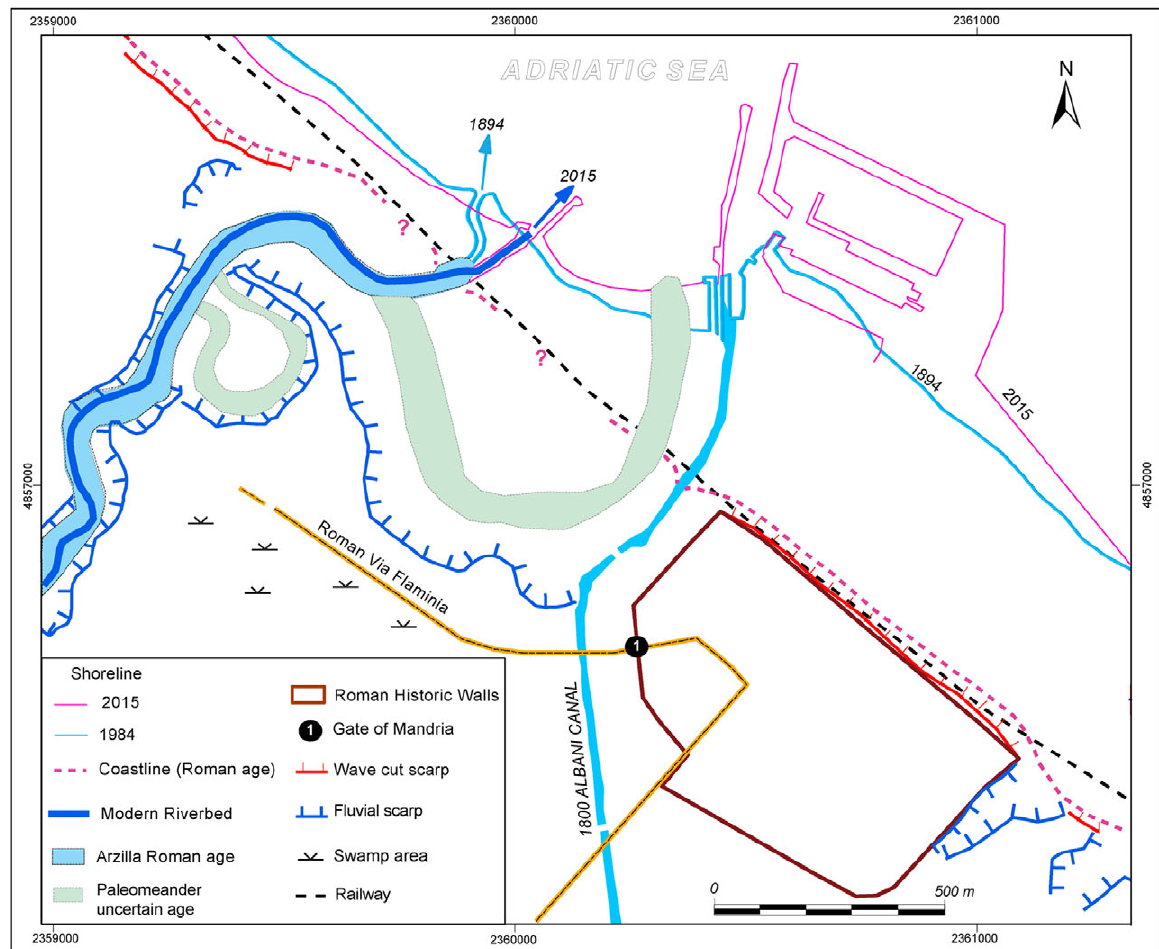
Fig. 5. Morpho-evolutive reconstruction of the Fano ( Fanum Fortunae )